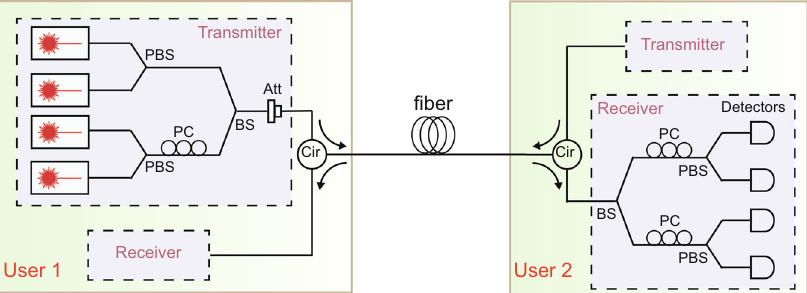
Fig. 2 A schematic for the QKD set-up. There are four laser sources in the transmitter emitting four corresponding polarization states in the BB84 protocol. The polarization is modulated via the PBS and the PC, and the average light intensity is modulated via the attenuator. Each laser produces three light pulses with different intensities including signal, decoy and vacuum states. The signal and decoy states contain mean photon numbers of 0.6 and 0.2 per pulse, respectively, and the ratio between the signal, decoy, and vacuum states is 6:1:1. The optical misalignment is less than 0.5%. In the detection side, a four-channel InGaAs single-photon detector is integrated with the following parameters. The detection ef fi ciency is 10%, the dark count is 10 − 6 , the dead time is 2 μ s, the afterpulse probability is less than 0.5% and the effective gate width is 500 ps. The receiver detects the light signal with the PC as a polarization feedback. The Cir is used to realize transmission and reception of light signals simultaneously. BS: beam splitter; PBS: polarizing beam splitter; PC: polarization controller; Att: attenuator; Cir: